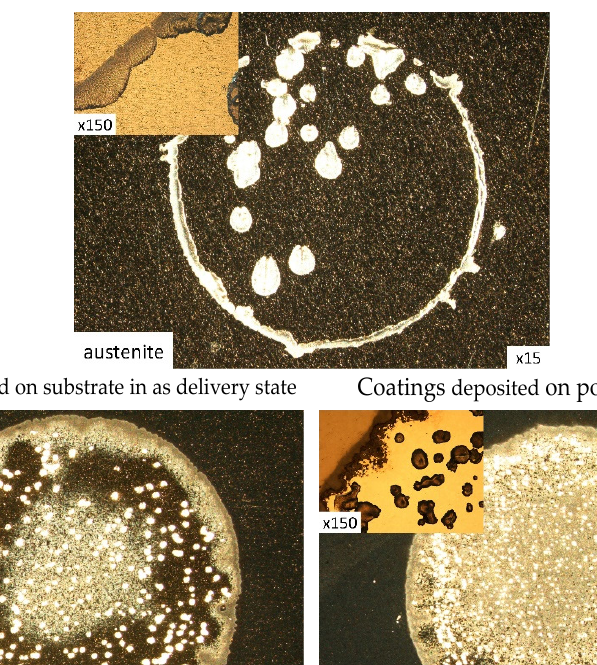
Figure 5. Top surface of coating: ( a ) S-phase (50 vol.% of N 2 )/Cr 2 N (substrate in as delivery state), ( b ) S-phase (50 vol.% of N 2 )/Cr 2 N (polished substrate) and ( c ) Cr/Cr 2 N (substrate in as delivery state) after potentiodynamic corrosion test, SEM.